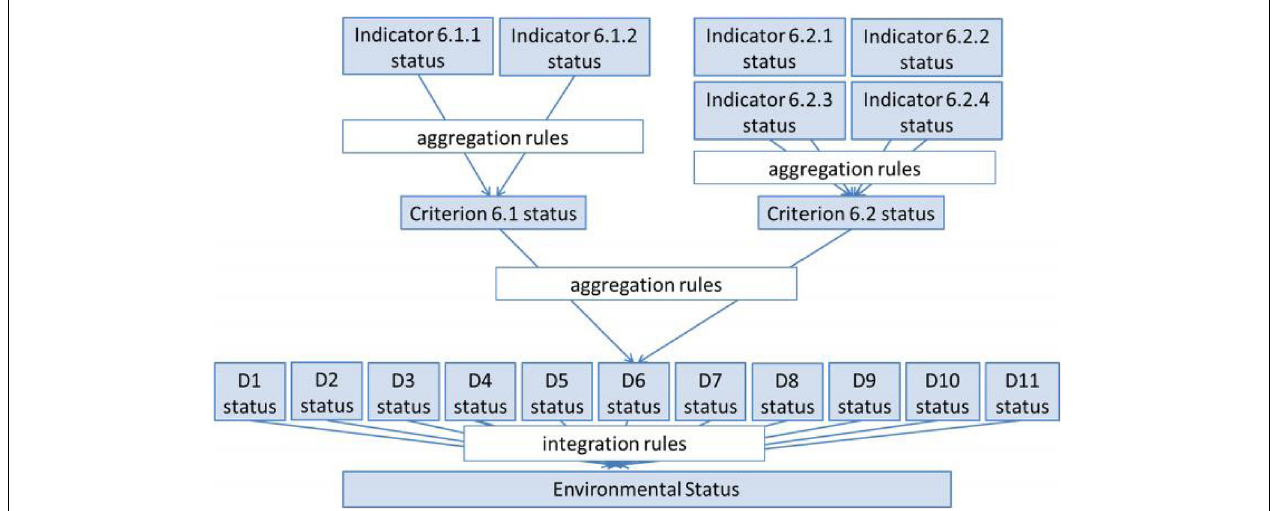
FIGURE 2 | Diagram of a possible approach for aggregation of indicators and criteria and integration of descriptors (D), using D6 as an example. For indicators and criteria description, see Table 1 .